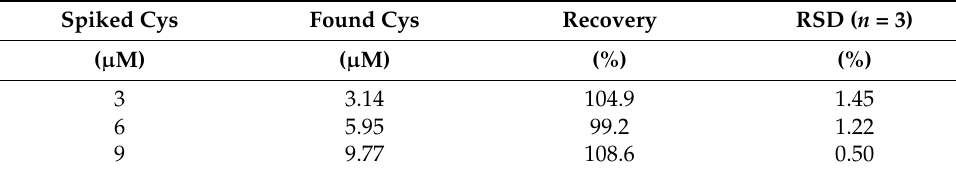
Table 1. Spike recovery test using real urine sample from a healthy volunteer.